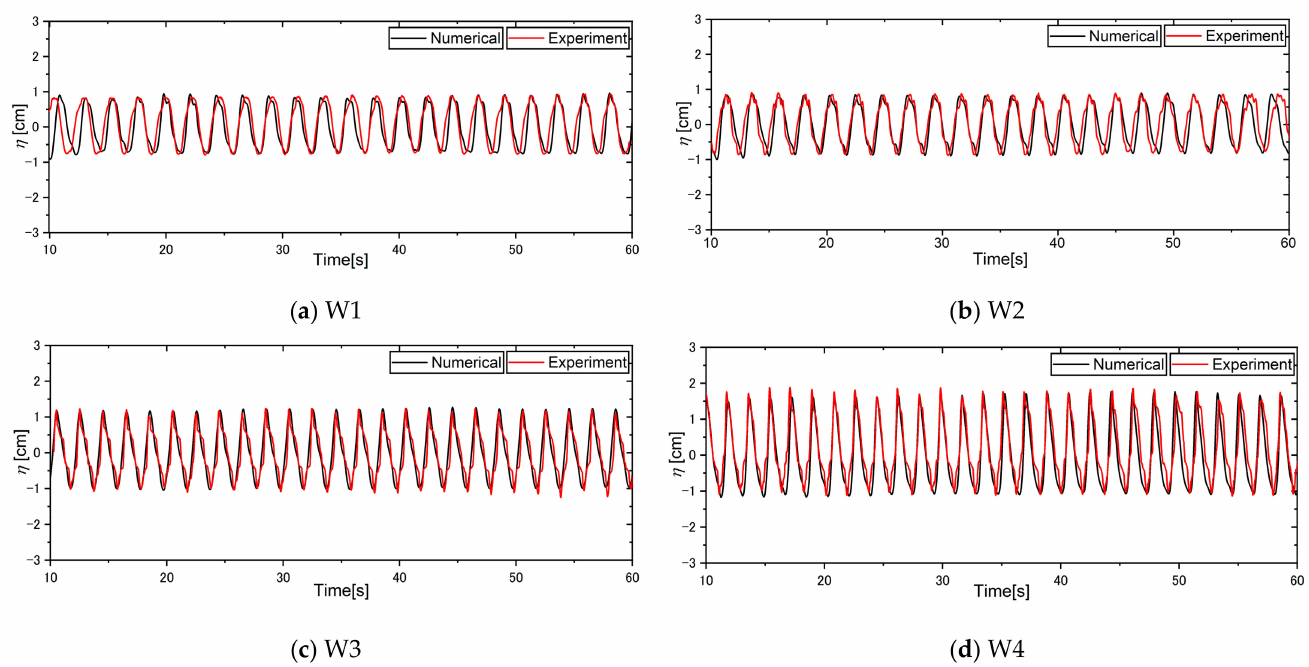
Figure 6. Water surface elevation profiles at corresponding wave gauges positions under different wave conditions: ( a ) T-2.22 s ( r = 264 cm), ( b ) T-2.22 s ( r = 300 cm ), ( c ) T-2.0 s ( r = 336 cm ), and ( d ) T-1.82 s ( r = 369 cm